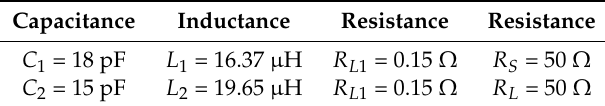
Table 2. Calculated base model of two-loop loosely coupled WPT system. The specification will be later used to built a practical